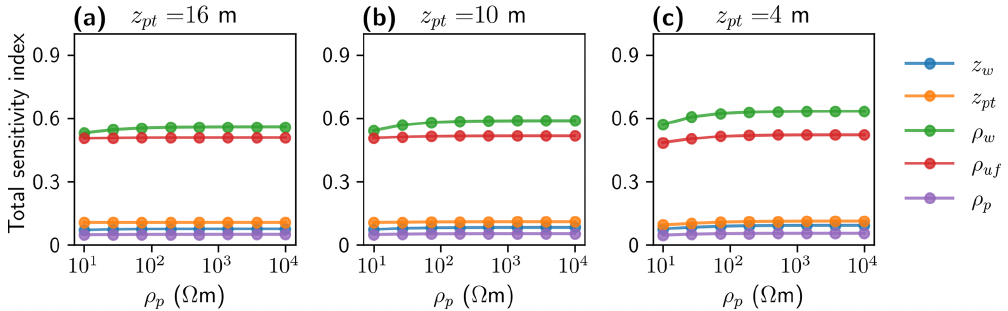
Figure 11. Global sensitivity results for the Drew Point field site considering different 1D model scenarios with an IBPT at a depth of (a) 16, (b) 10, and (c)